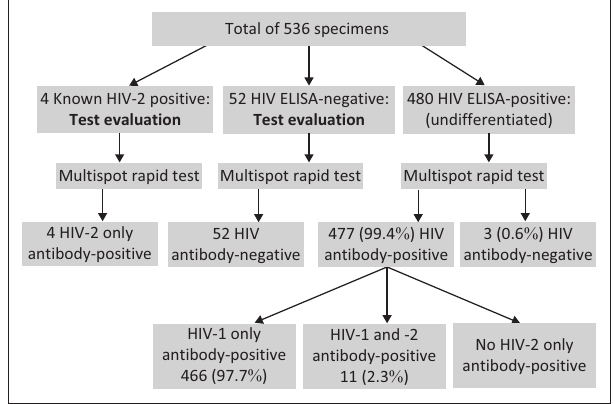
FIGURE 1: Algorithm of the specimens tested with Multispot HIV-1/2 rapid